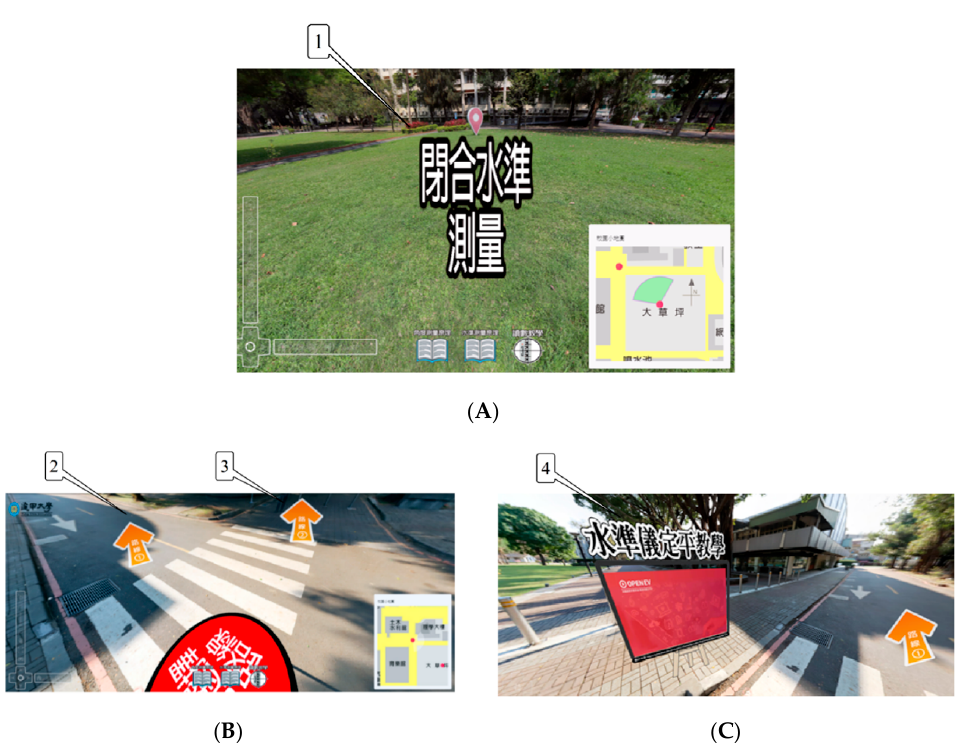
Figure 11. Webpage for teaching the elevation-based measurement. ( A ) Entrance for angle-based measurement (symbol 1, or called leveling measurement); ( B ) Route selection (symbols 2 and 3 represent routes 1 and 2, respectively); ( C ) Teaching video (symbol 4) for setting up the instrument.